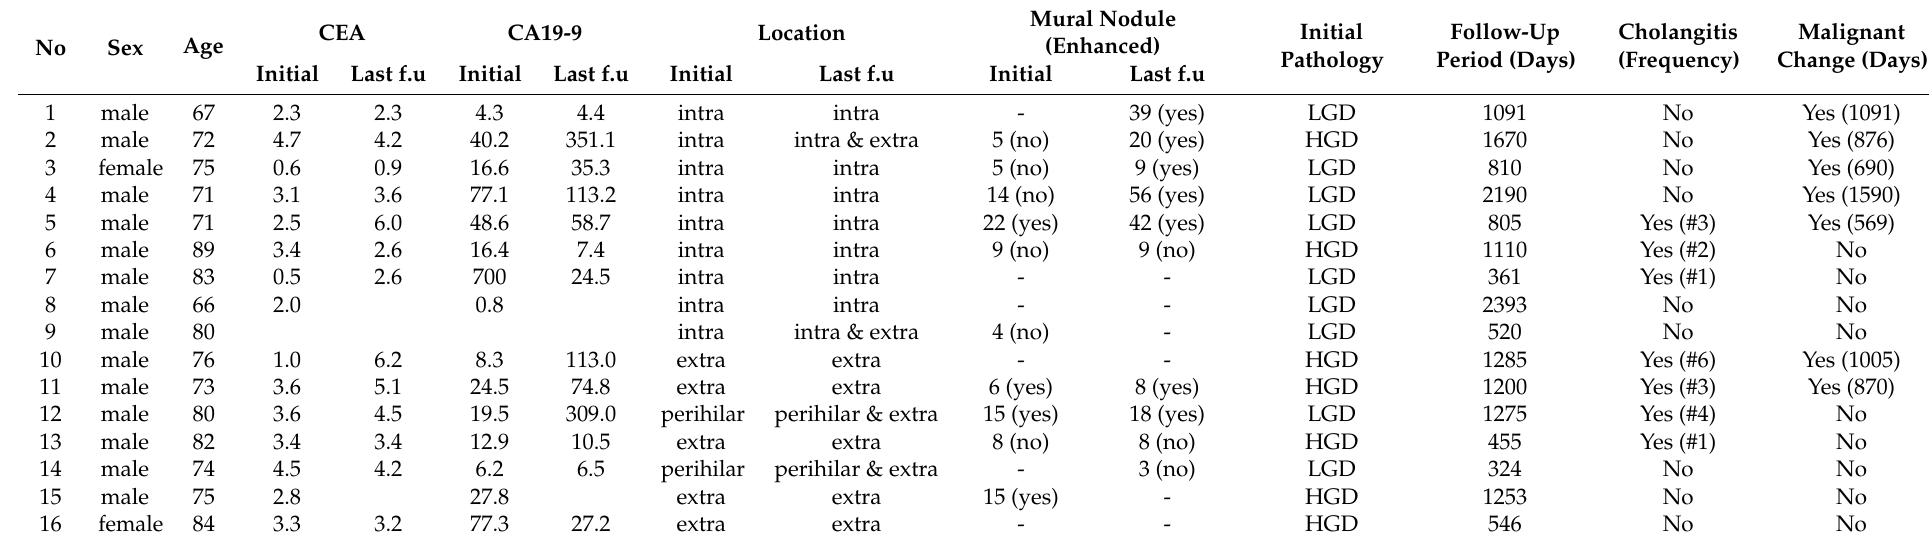
Table 6. clinical information of patients with IPNB without